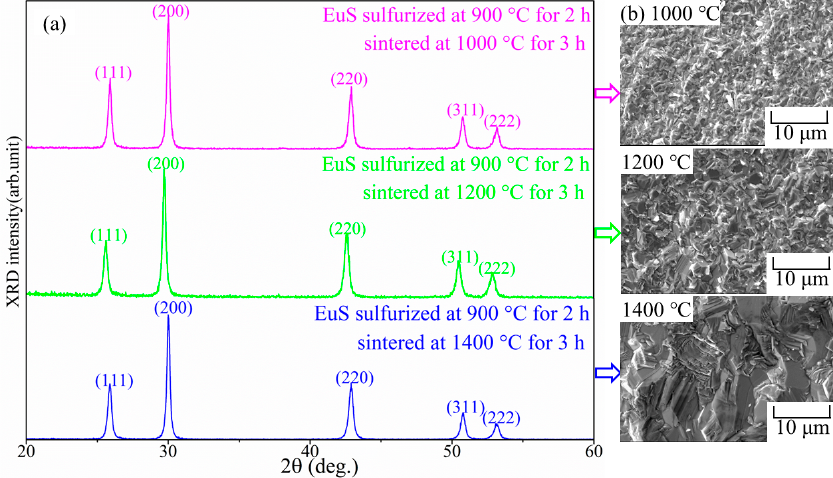
Figure 1. XRD patterns ( left side , a ) and SEM images ( right side , b ) of EuS bulks prepared by SPS.